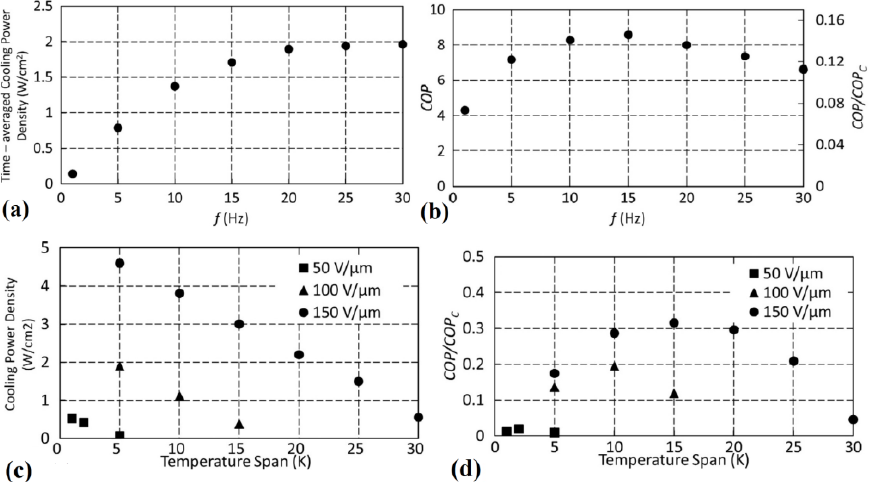
Figure 9. An extract of the results on cooling power density and coefficient of performance introduced by Guo et al. (reprinted with permission from [35], Elsevier, 2014).